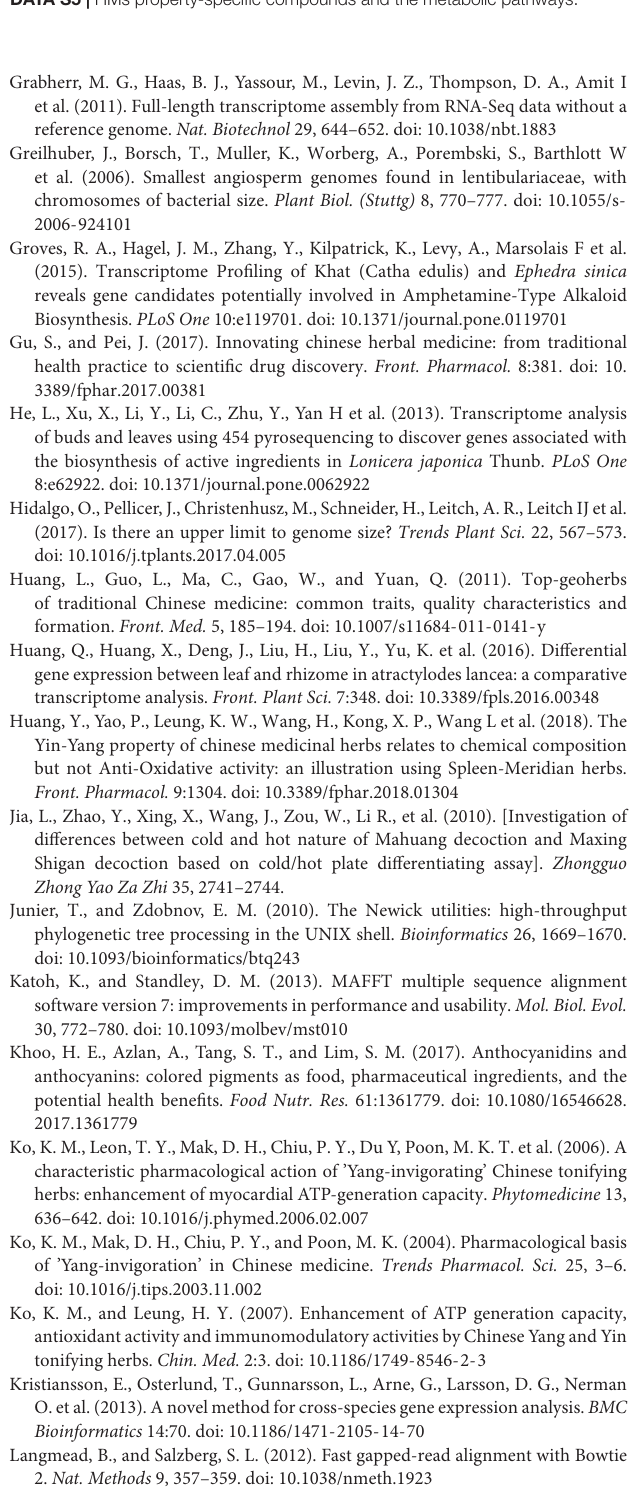
TABLE S3 | Sample sequencing data quality evaluation. TABLE S4 | Statistics for de novo transcriptome assembly of each sample. DATA S1 | Cross-species gene expression analysis results. DATA S2 | Organ-specific genes and enriched GO terms.